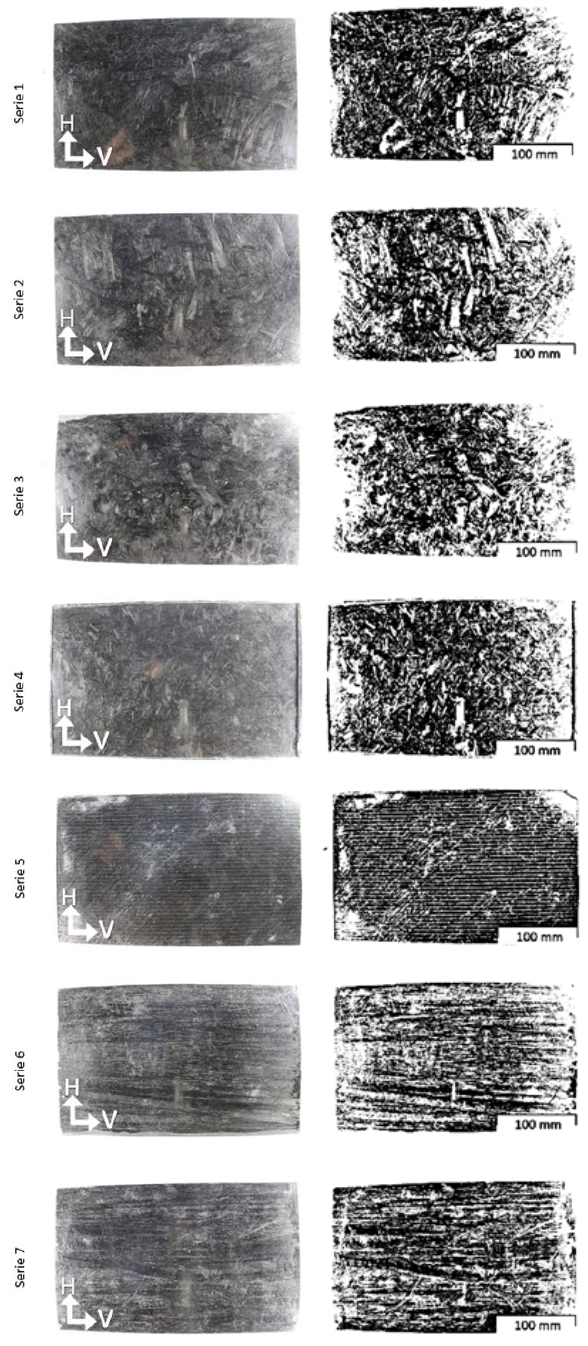
Figure 1. Macro-scale photographs of surfaces of sample panels: left column—raw data, right column—data after binarization, where H is bending direction along the fiber placement direction and V is bending direction perpendicular to the fiber placement direction .